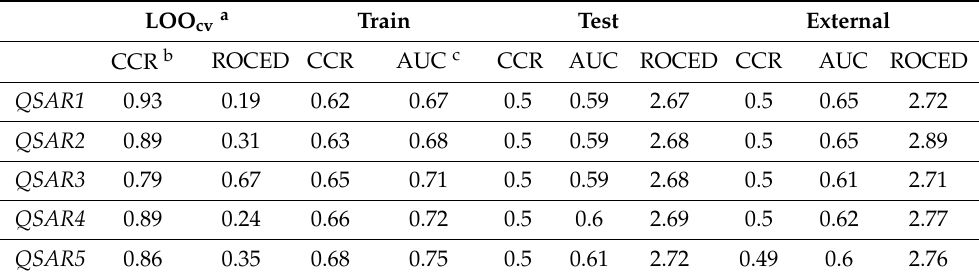
Table 2. Leave-one-out cross-validation and Y-randomization parameters of QSAR models. LOO cv a Train Test